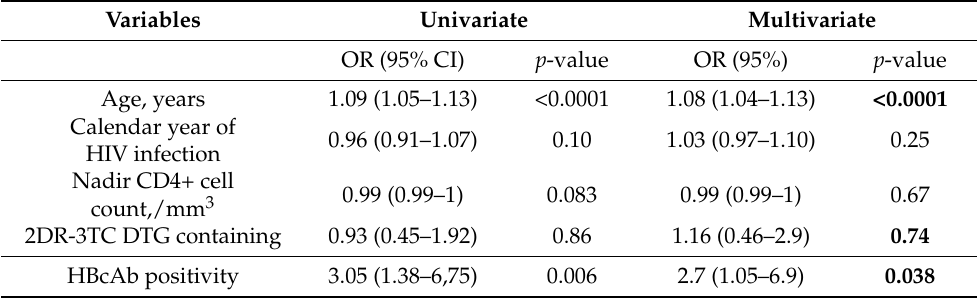
Table 4. Univariate and multivariate analyses for estimated factors with predictive impact on detectable HIV RNA 24 months after the 2DR-3TC-based